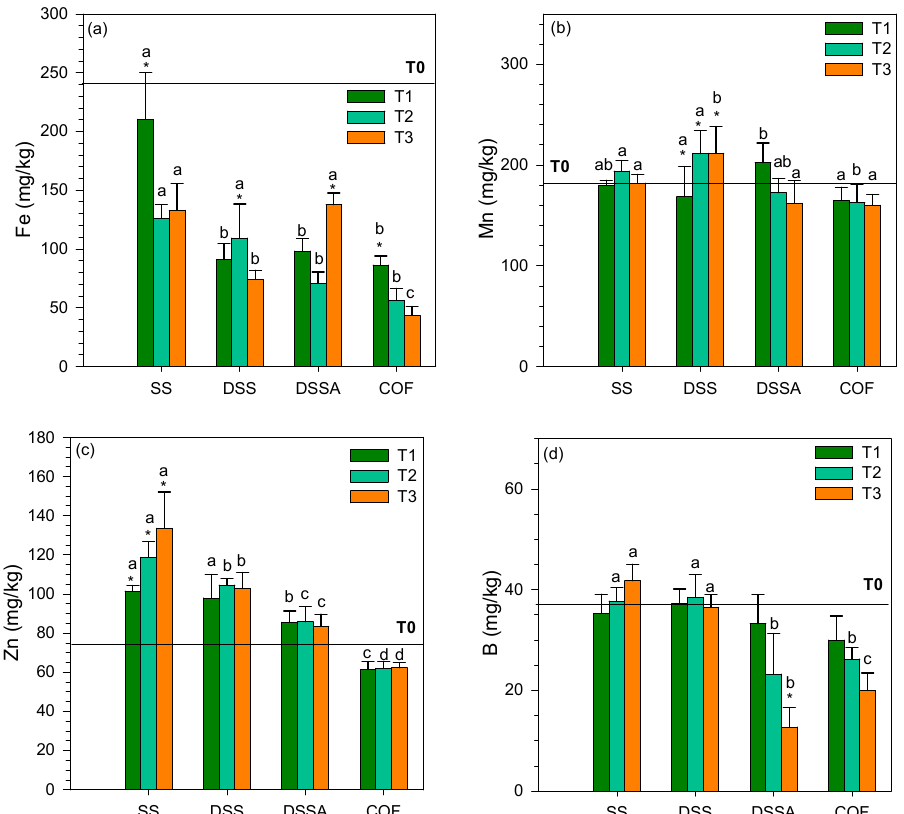
Figure 5. Micronutrient content ( a ) iron; ( b ) manganese; ( c ) zinc; ( d ) boron in the dried biomass of lettuce for the different added soil amendments (T0—0 kg N/ha; T1—85 kg N/ha; T2—170 kg N/ha; T3—255 kg N/ha; mean values and standard deviations obtained in four replicates of each treatment; different letters indicate statistical differences between materials; * indicate statistical differences between treatments within each material; the statistical analysis was conducted separately for each figure).